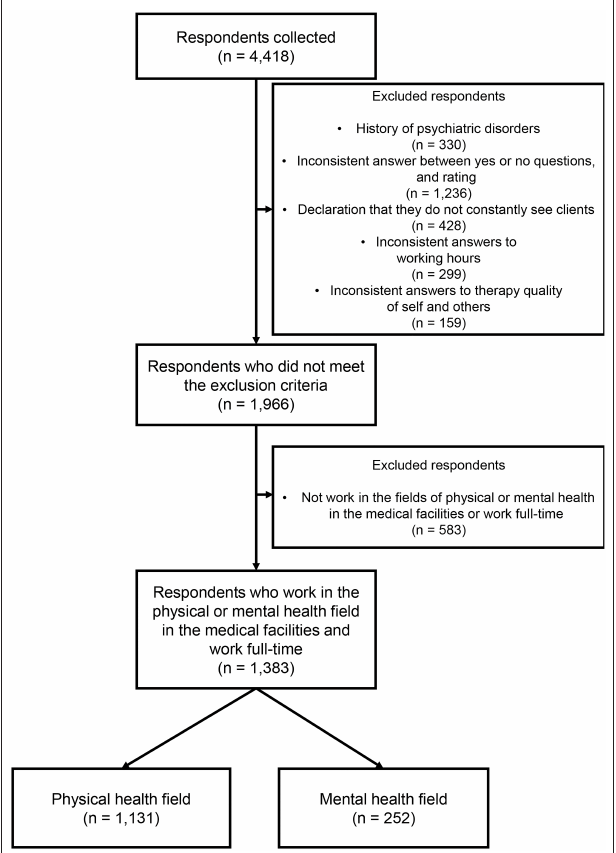
FIGURE 1 | Flow diagram for the respondents included in data analysis. Flow chart summarizing the number of respondents excluded with implementation of each eligibility criteria culminating in the final analytical data set ( n = 1,383, OTs in the physical health field: n = 1,131; OTs in the mental health field: n =